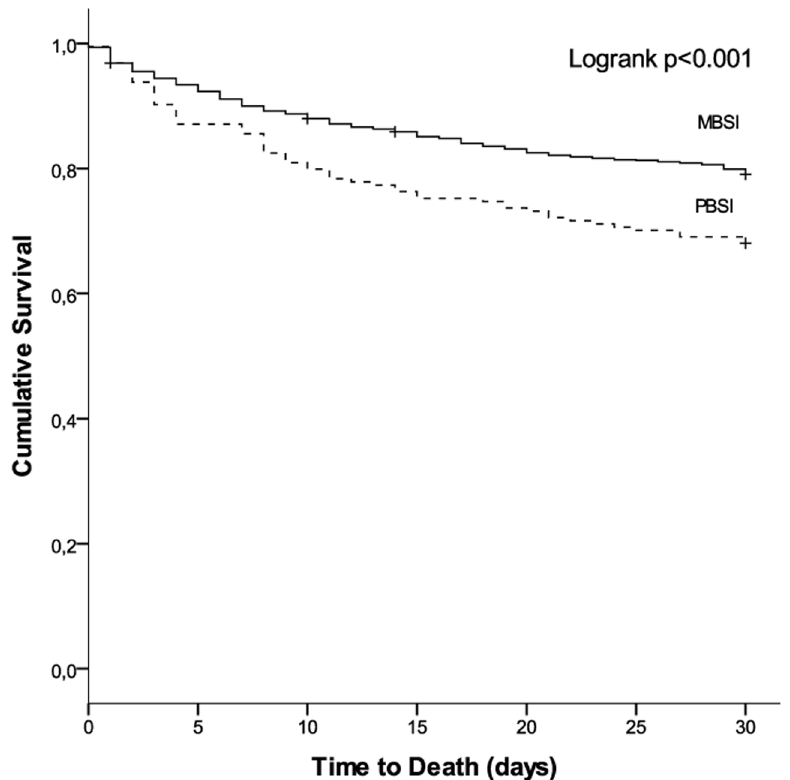
Fig 1. Kaplan–Meier survival curves of patients with polymicrobial bloodstream infection and monomicrobial bloodstream infection.